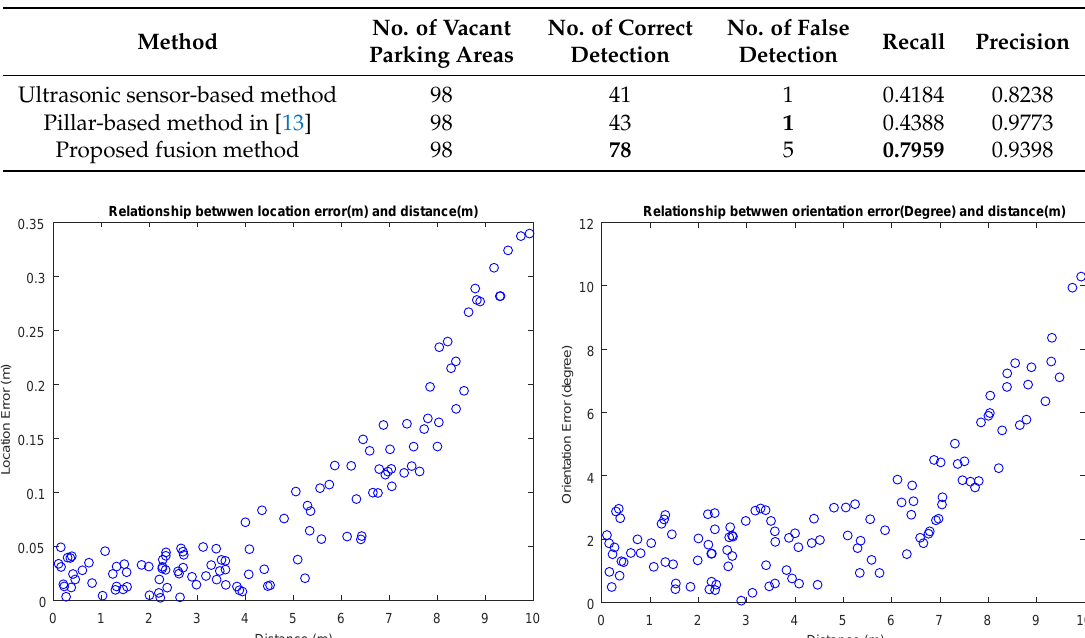
Table 4. Performance comparison of parking area detection methods in GN.